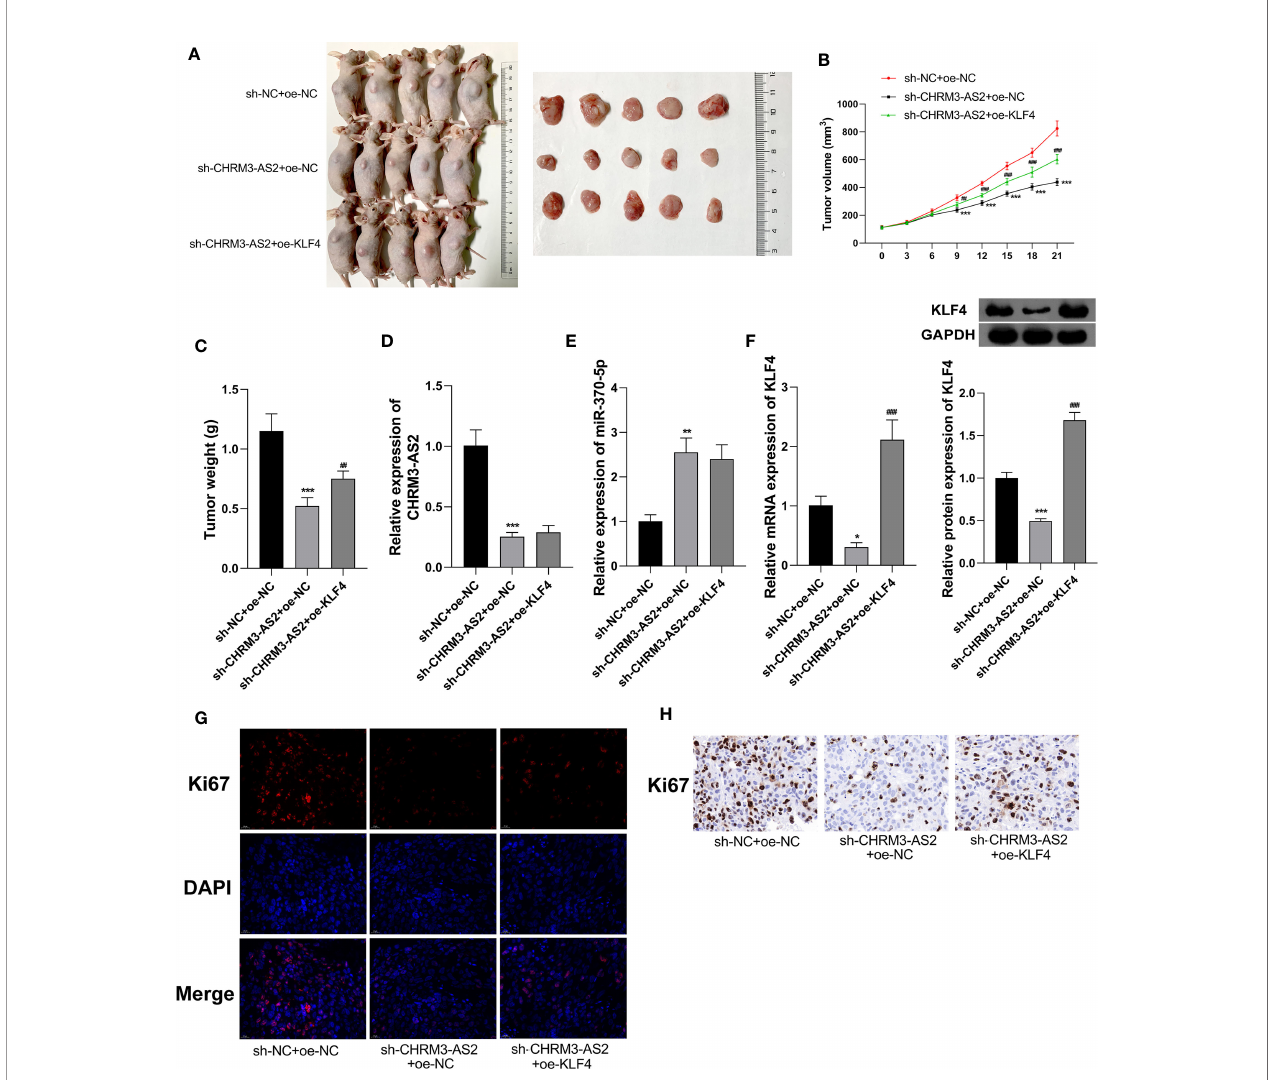
FIGURE 7 | Silencing of CHRM3-AS2 expression inhibited tumour growth in a mouse tumour xenograft model by regulating miR-370-5p/KLF4 axis. (A) Tumour morphology. (B) Tumour volume. (C) Tumour weight. (D) Expression of CHRM3-AS2 was quanti fi ed via qRT-PCR. (E) Expression of miR-370-5p was quanti fi ed via qRT-PCR. (F) The mRNA and protein expression of KLF4 was quanti fi ed via qRT-PCR and western blotting, respectively. (G) Expression of Ki67 was detected via IF. (H) Expression of Ki67 was detected via IHC. Mice were injected with U251 cells co-transfected with sh-CHRM3-AS2/sh-NC and oe-KLF4/oe-NC. *P < 0.05, **P < 0.01, ***P < 0.001 vs. sh-NC + oe-NC; ## P < 0.01, ### P < 0.001 vs. sh-CHRM3-AS2 +